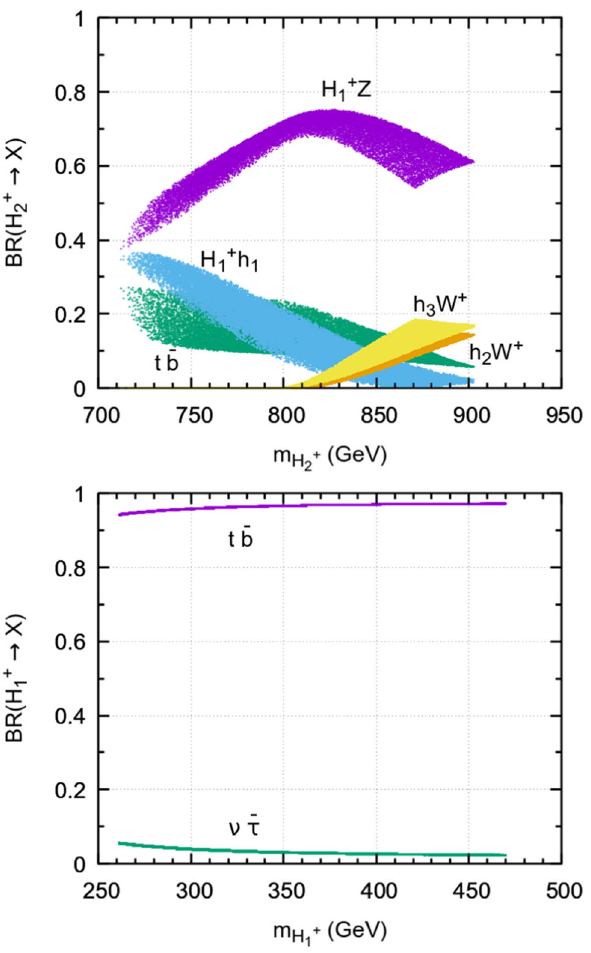
Fig. 13 Dominant BR’s for H + (upper panel) and H + (lower panel) 2 1 for benchmark point P 4 versus the charged Higgs masses